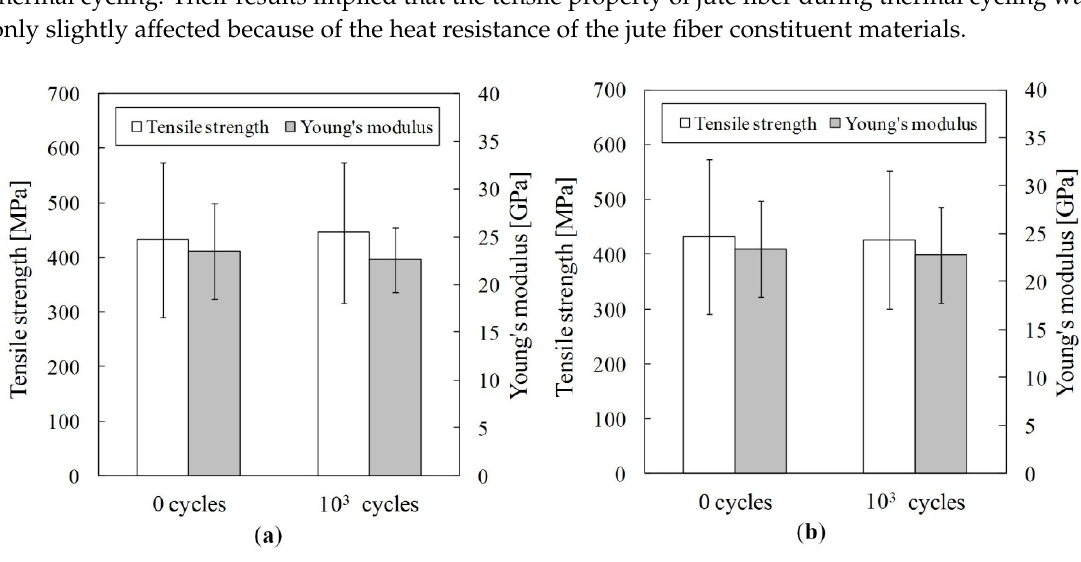
Figure 6. Tensile property of jute fiber after thermal cycling: ( a ) 35–45 °C; ( b ) 35–55 °C.